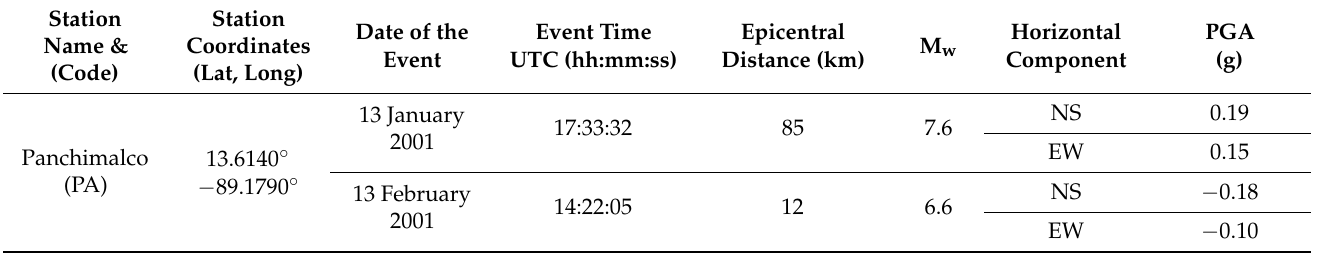
Table 6. Input accelerograms of 13 January and 13 February 2001 selected by COSMOS Virtual Data Center